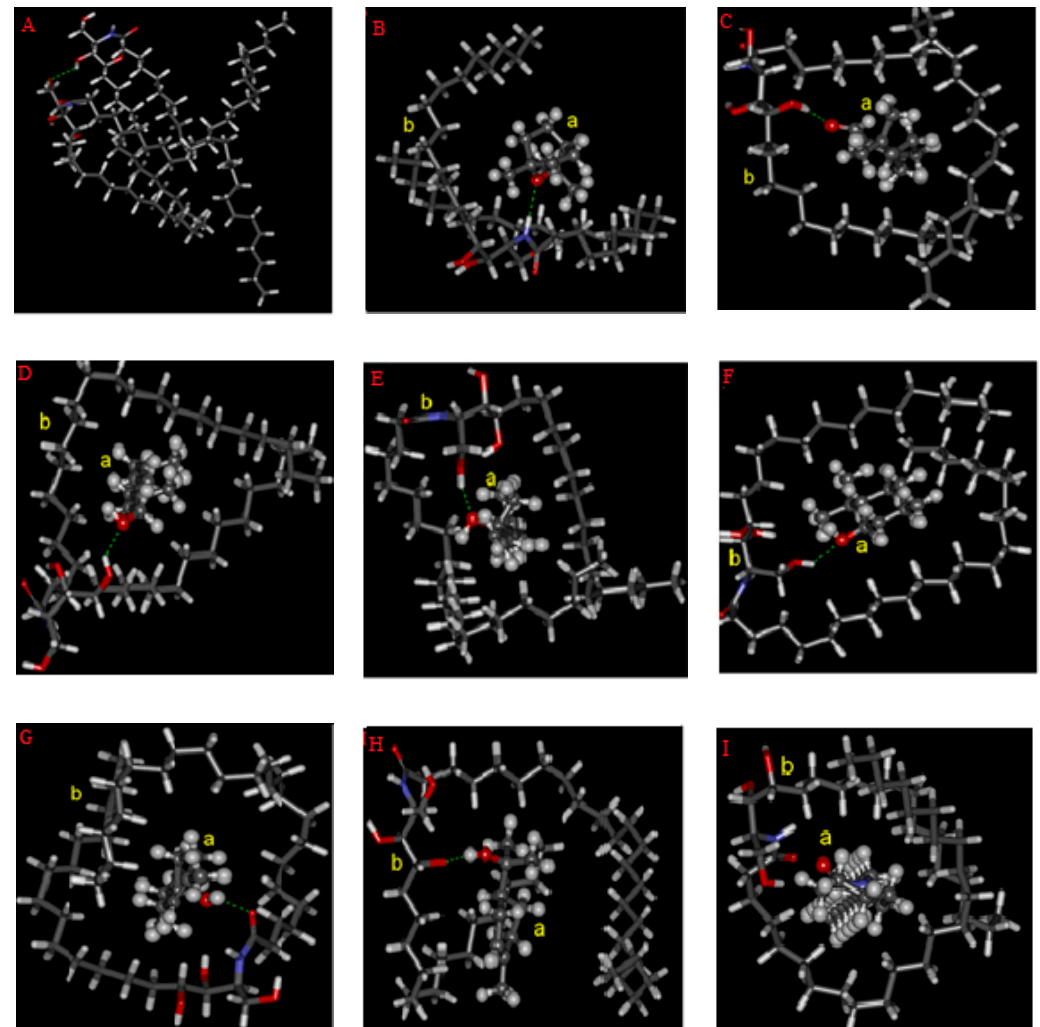
Figure 6. The stable complexes of ceramide 3 and oxygen-containing terpenes. ( A ) Ceramide 3 and Ceramide 3; ( B ) 1,8-Cineole, ( C ) Citral, ( D ) Geraniol, ( E ) Linalool, ( F ) Menthol, ( G ) Terpinen-4-ol, ( H ) α -Terpineol, ( I ) Azone. (Note: a. oxygen-containing terpenes; b. ceramide 3).